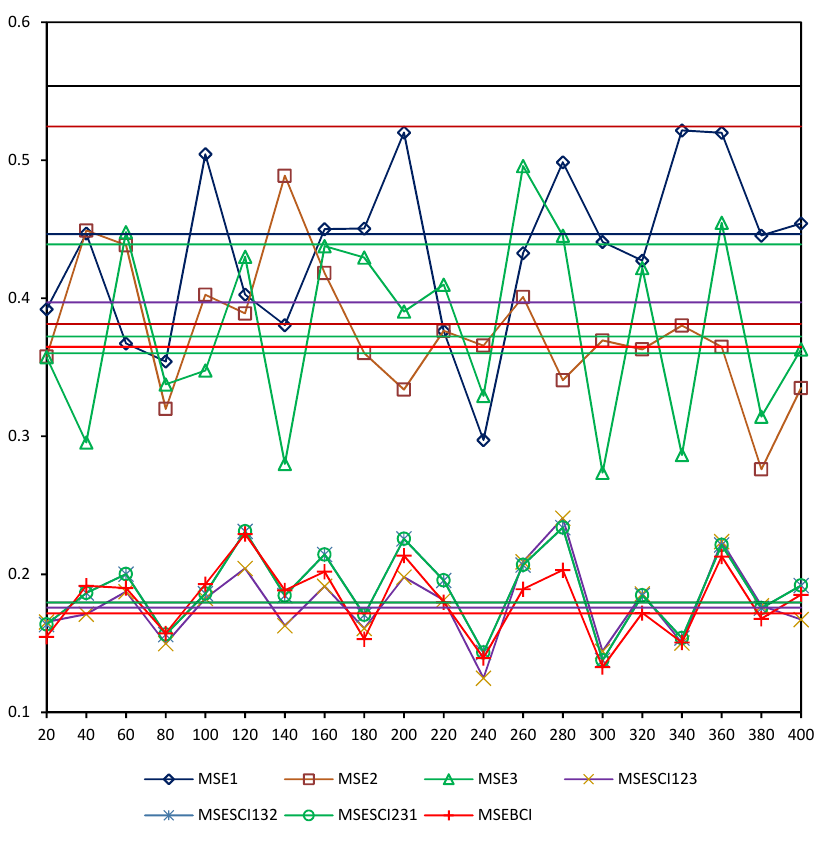
Figure 10. The comparison of MSE i ( t ) and tr P i , i = 1,2,3, SCI 123, SCI 132, SCI 231, BCI . Example 2. In order to show the sensitivity of the actual and robust accuracies for the SCI fuser with respect to the orders of sensors, consider a 4-sensor tracking system with uncertainties of noise variances